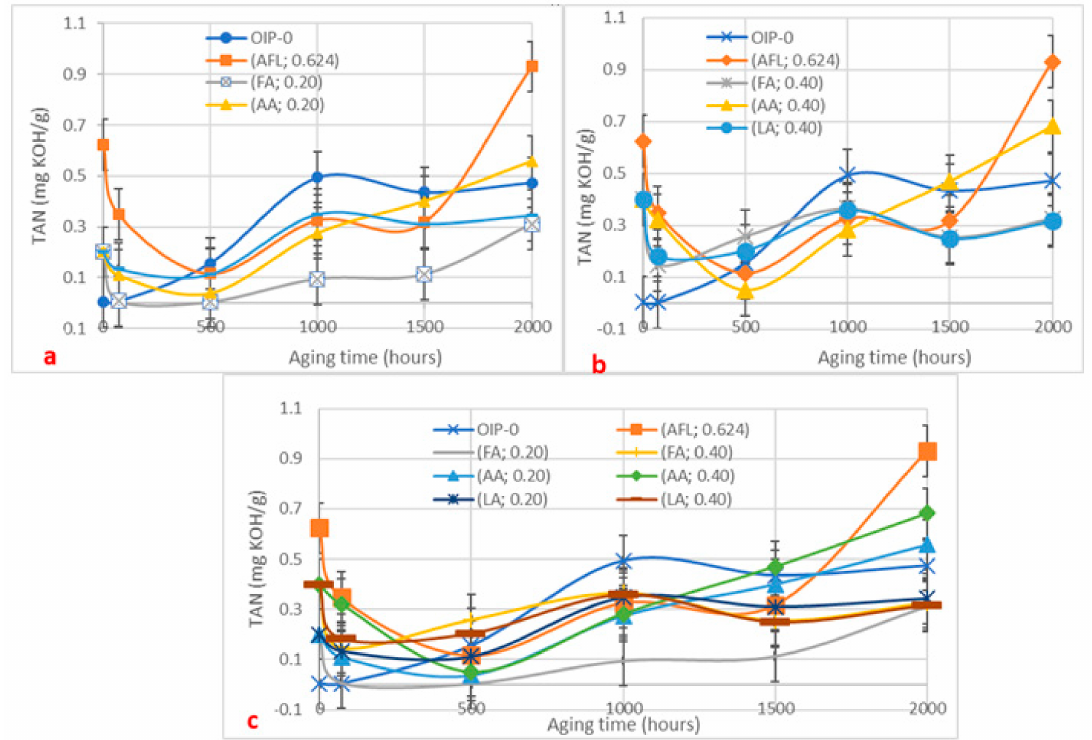
Figure 4. TAN (Total Acid Number) in oil as function of aging duration, for samples mixed with three different acids (formic, acetic and levulinic): ( a ) 0.20 mg KOH/g and ( b ) 0.40 mg KOH/g for three different acids (formic, acetic and levulinic), acid mixture and also for acid-free oil. The results are summarized in Figure ( c ) for better